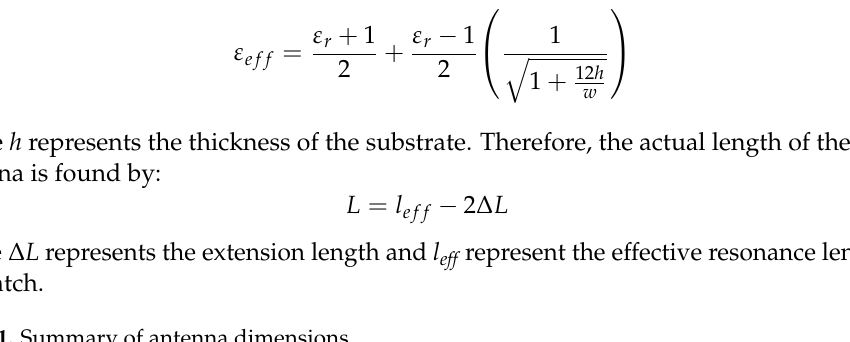
Table 1. Summary of antenna